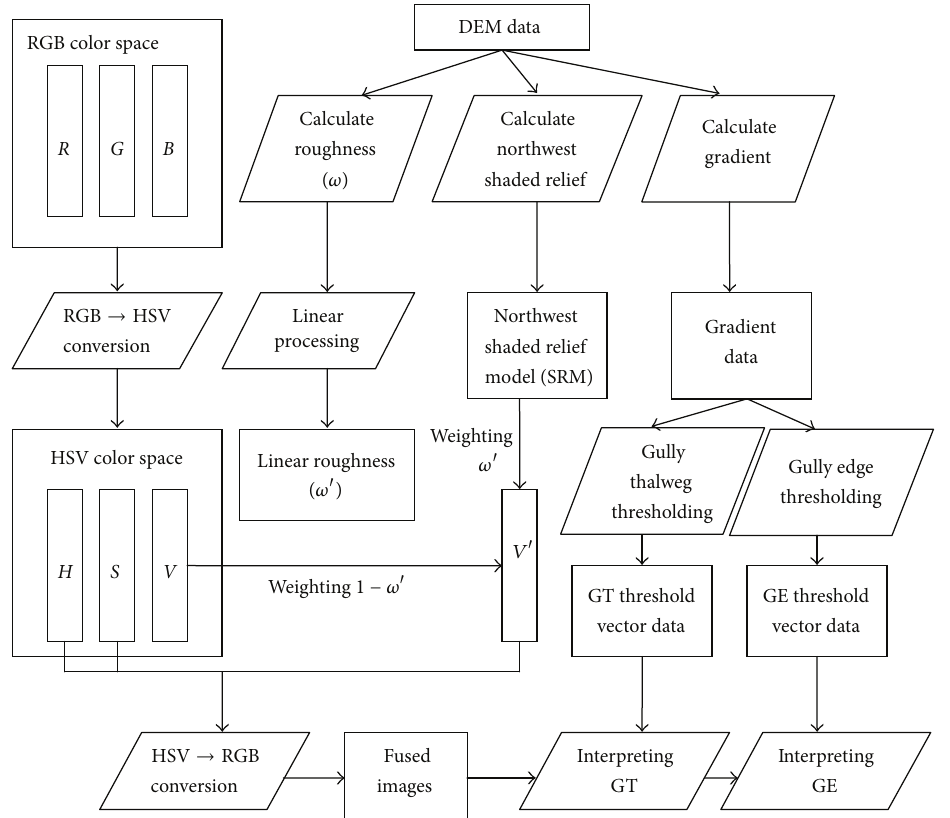
Figure 2: Schematic diagram of the interpreting gully edge from Quickbird image/Northwest SRM fused